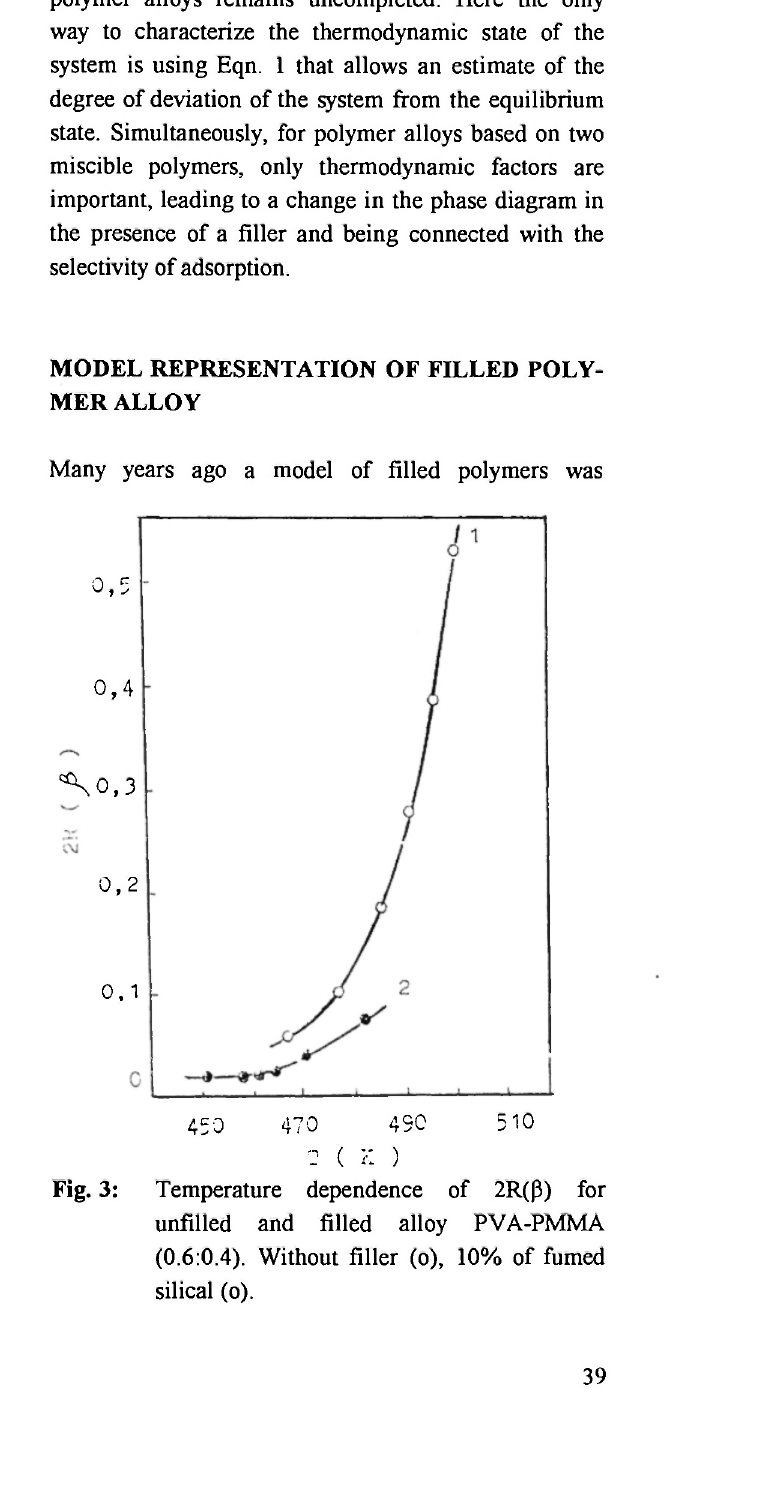
Temperature 2R(ß) for unfilled and filled alloy (0.6:0.4). Without filler (o), 10% of fumed silical